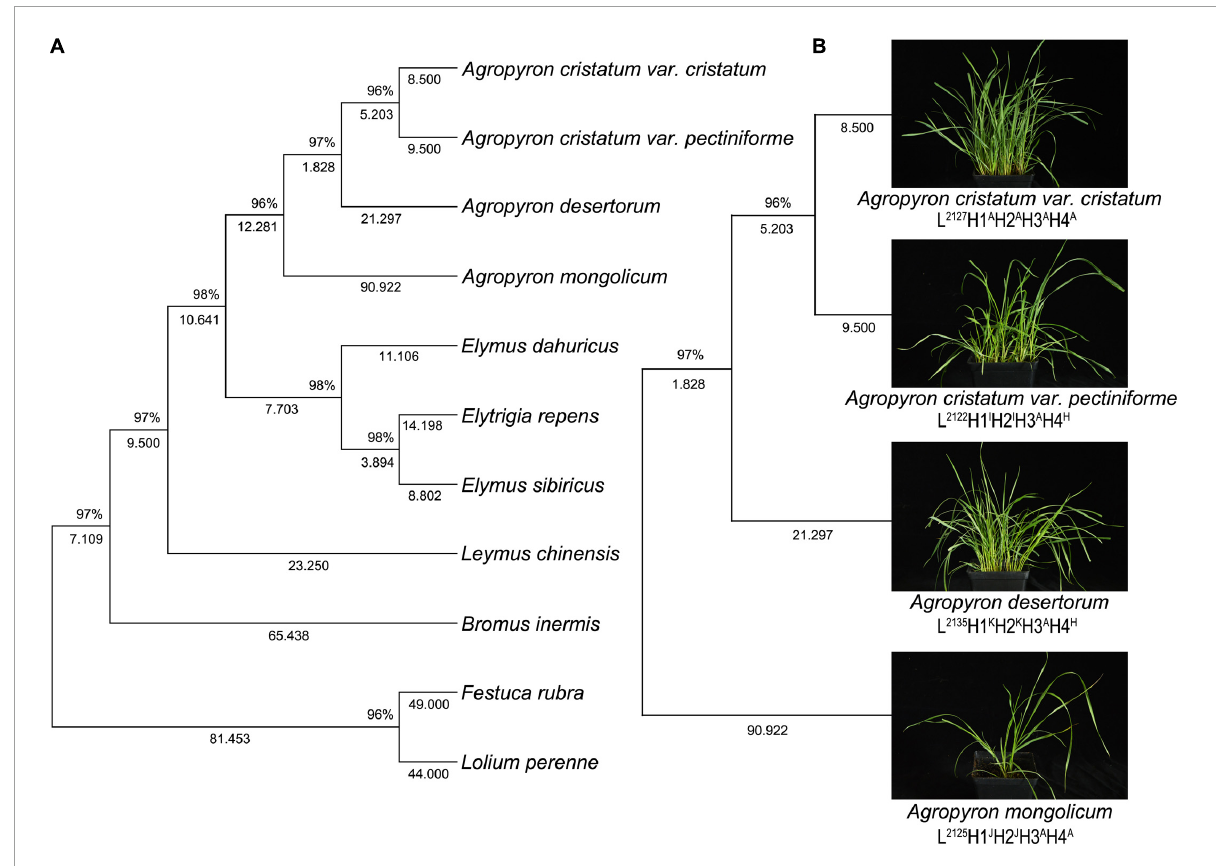
FIGURE3 Topology resulting from Neighbor-Joining analysis of one 4-gene dataset using MEGA X. Neighbor-Joining analysis of one 4-gene dataset of 14 samples of grass belonging to Gramineae (A) , neighbor-Joining analysis of one 4-gene dataset in 4 samples of Agropyron species (B) .